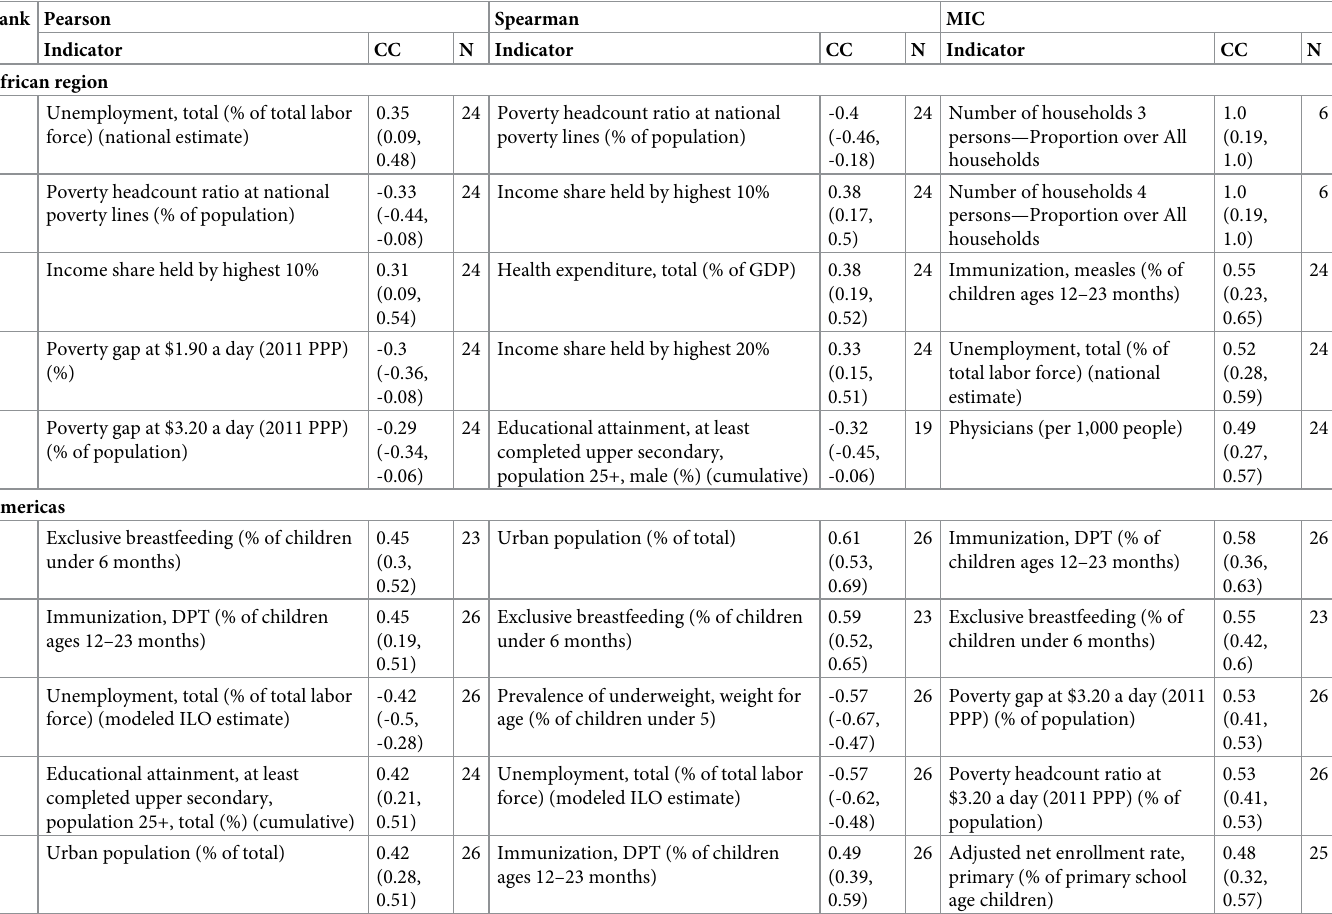
Table 2. Summary of the top five correlation coefficients and MIC for the association between the basic reproduction number and the indicators, obtained consid- ering estimates of the basic reproduction number just for countries in the African region or the Americas. The columns labelled “CC” hold the coefficient, with the 95% range obtained by bootstrapping; the column labelled “N” holds the number of data points used to calculate the